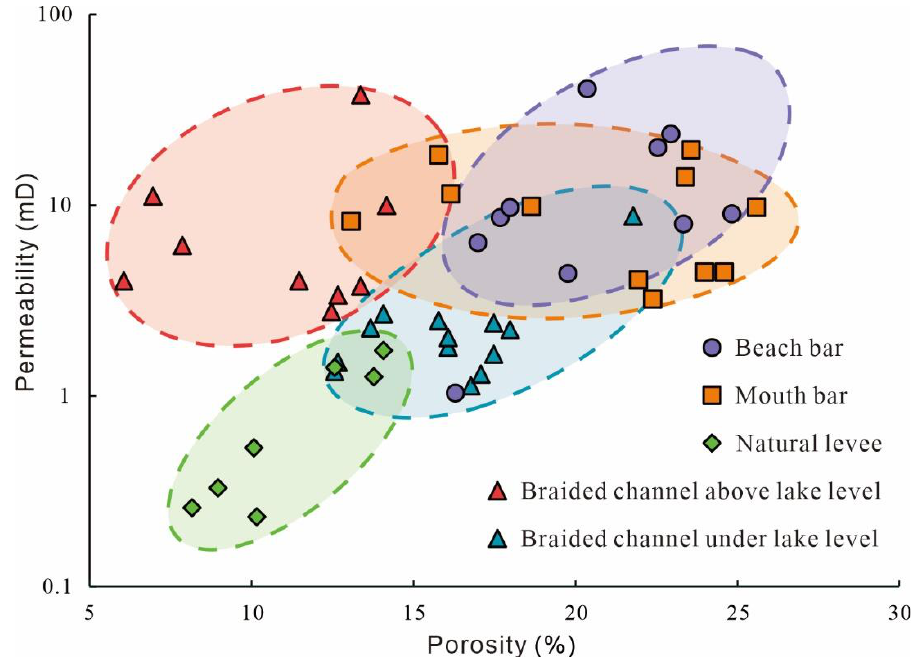
Figure 12. Physical properties of the reservoirs in the various facies of the Jiucaiyuan Formation in the Beisantai Uplift.